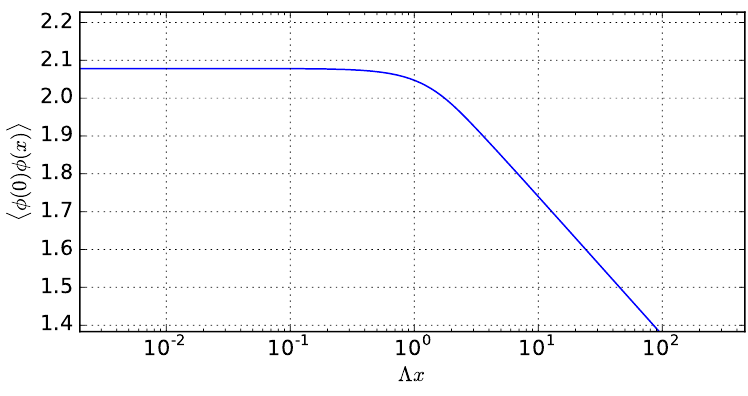
Figure 4 . h (cid:30) (0) (cid:30) ( x ) i correlator computed for a cMERA de(cid:12)ned by 3.12. Notice the existence of two clearly di(cid:11)erent regimes delimited by (cid:3) x (cid:24) 1. These results were obtained with an IR regulator with " = 10 (cid:0) 6 .